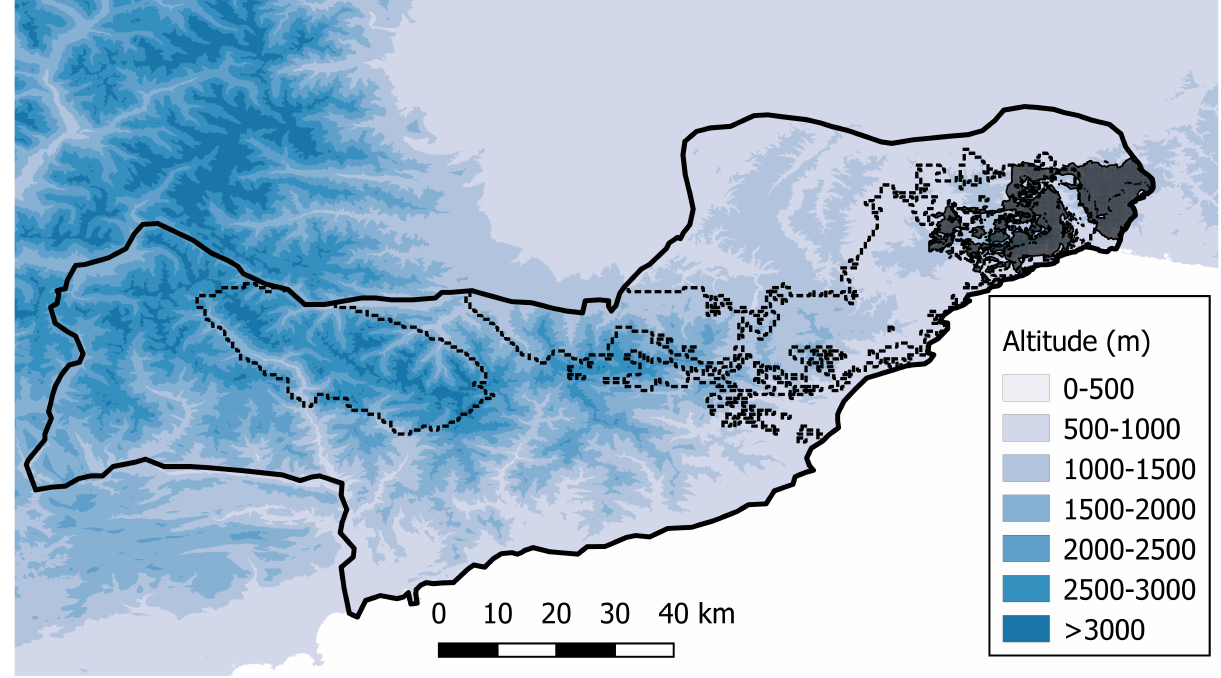
FIGURE 1. Map of Maritime and Ligurian Alps showing major geographic areas. Siliceous outcrops (dotted areas) and ophiolitic substrate (grey areas) are evidenced. The remnant area corresponds to calcareous outcrops. Elevation is showed in a blue scale. Dark blue shows highest altitude while light blue shows lowest